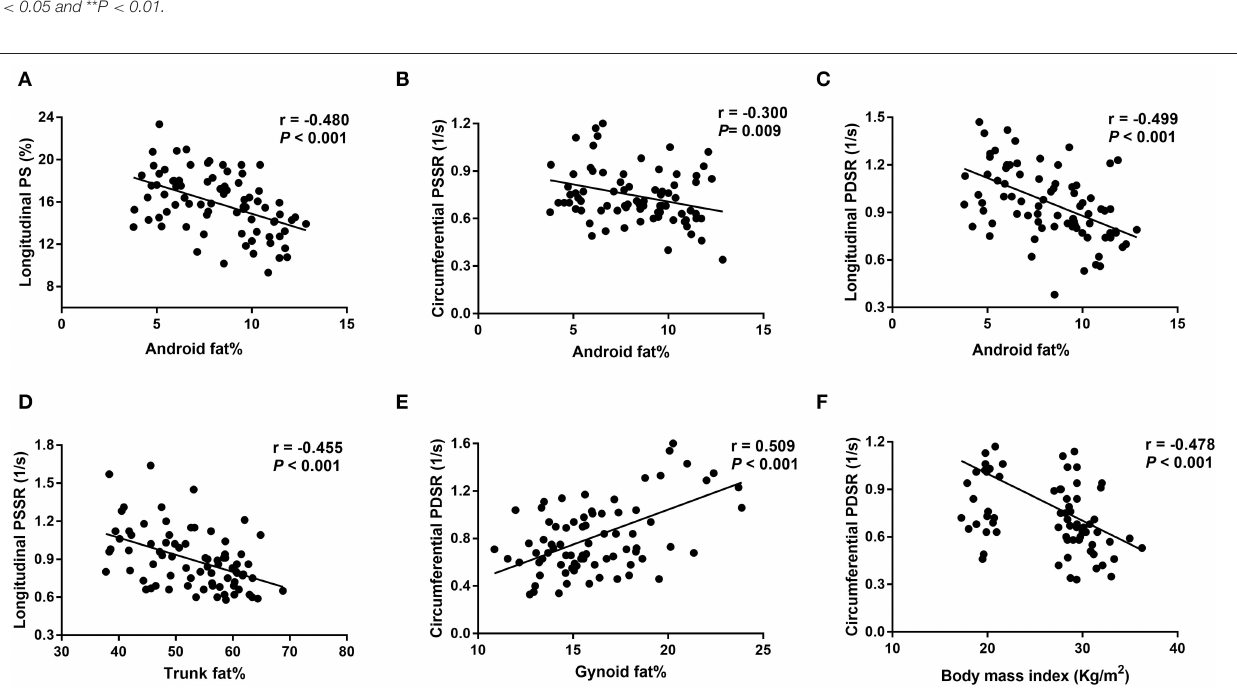
FIGURE 3 | Correlations between fat distributions and right ventricular strain parameters. (A-C) Show negative correlations between android fat% and longitudinal PS, longitudinal PDSR and circumferential PSSR; (D) shows a negative correlation between trunk fat% and longitudinal PSSR; (E) shows a positive correlation between gynoid fat% and circumferential PDSR; (F) shows a negative correlation between body mass index and circumferential PDSR. PS, peak strain; PSSR, peak systolic strain rate; PDSR, peak diastolic strain rate. Longitudinal PS and longitudinal/circumferential PSSR are showed as absolute